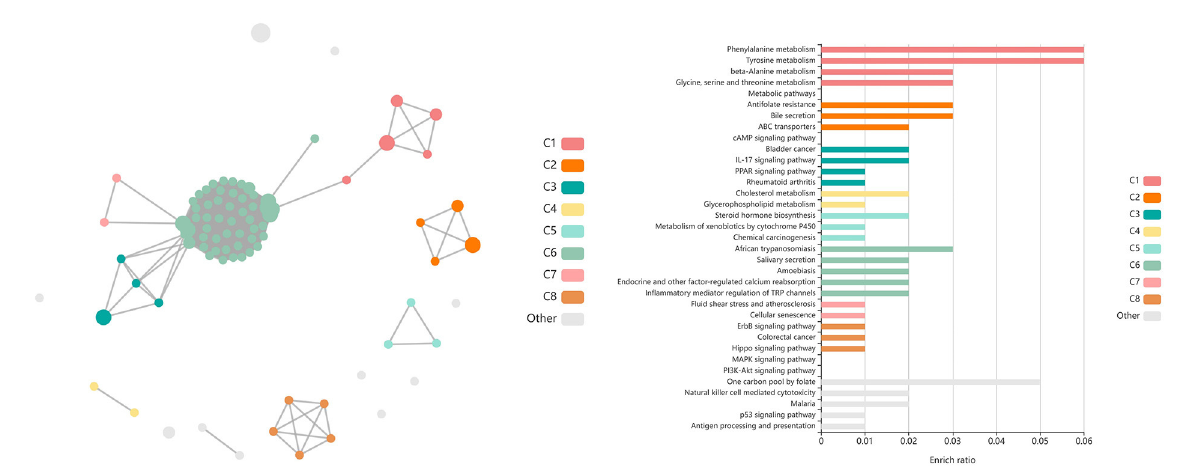
FIGURE10 Clustering of enriched KEGG pathways by term identity from KOBAS-i analysis of DEGs identified from glmmSeq evaluation of the interaction between vaccination and time. Each node represents an enriched term, with color corresponding to the unique cluster based on term identity. Each edge (line between nodes) represents a significant correlation between pathway terms. Bar graphs represent the pathway terms found within each pathway (by color) and the level of enrichment (Enrich ratio). KEGG pathways identified through the interaction of vaccination and time clustered into eight unique clusters. Gray nodes and bar graphed terms represent enriched pathways which did not associate within the clustering model.